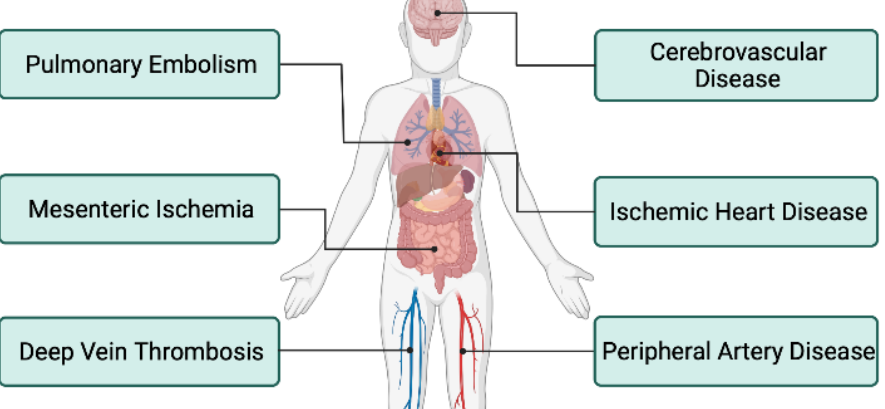
Figure 2. Arterial and venous thrombosis associated with IBD.